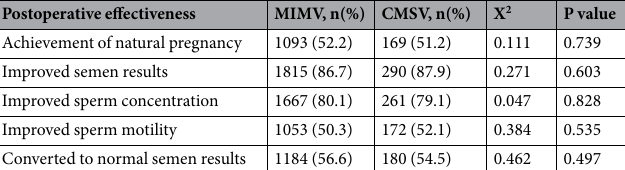
Table 3. Postoperative effectiveness for patients with low semen quality